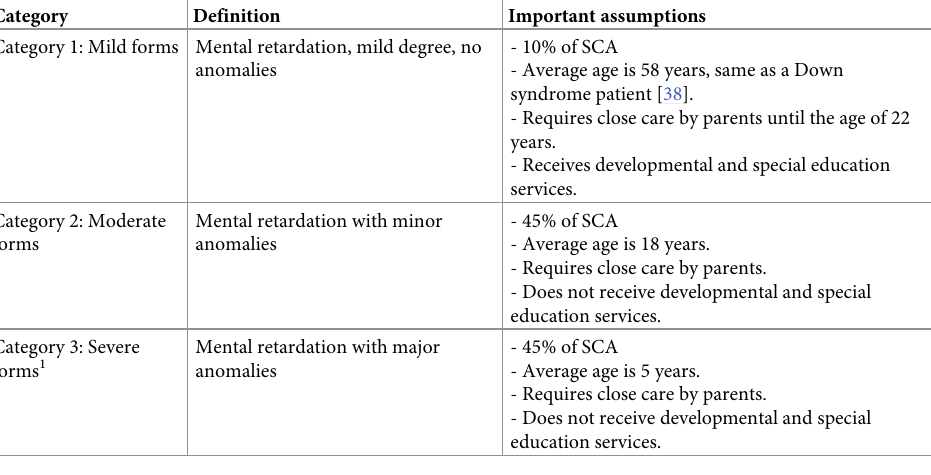
Table 1. Categories of structural chromosome abnormalities (SCA) and important assumptions used in the